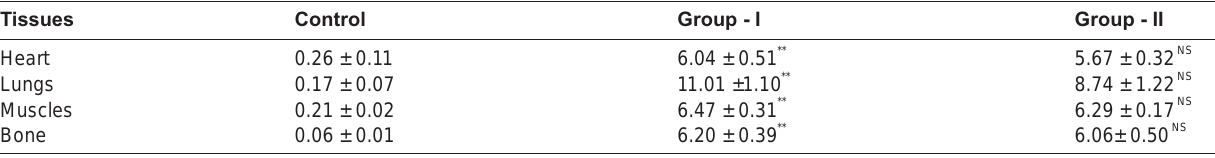
** P < 0.01 ; statistically significant when compared to control group. NS; statistically non-significant when compared to group – I.